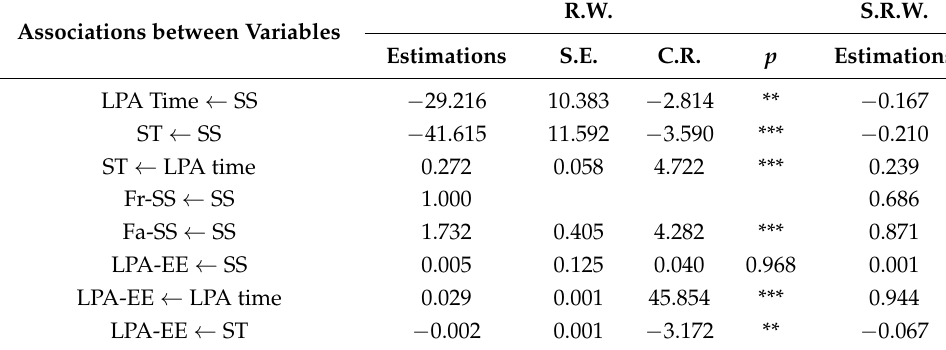
Figure 2. Theoretical model proposed in relation to MVPA. Moderate–Vigorous Physical Activity